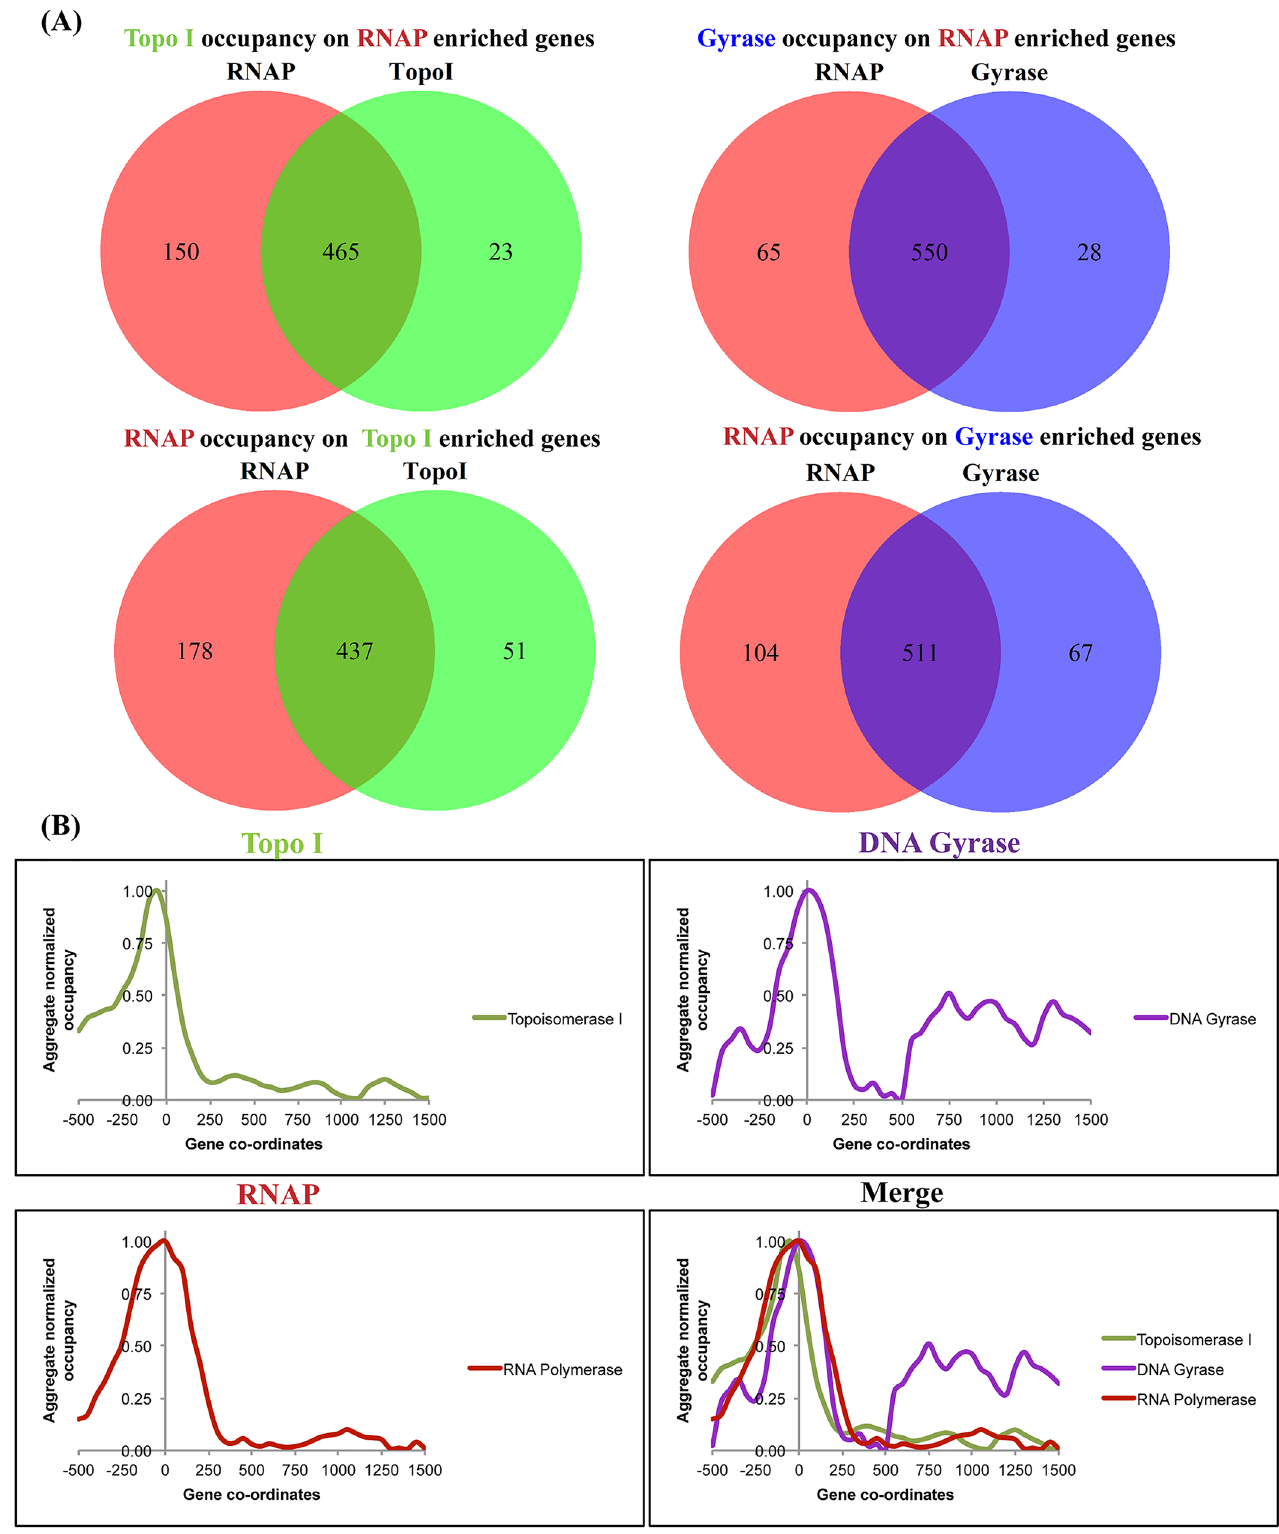
Fig 2. Topo I, RNAP and DNA gyrase co-localize on TUs. (A) TopoI, gyrase and RNAP association. Enrichment ratio (ER) for Topo I, Gyrase and RNAP was calculatedon protein coding genesas describedearlier[22] and in Materialsand Methods. RNAP and topoisomerase enrichedgenes